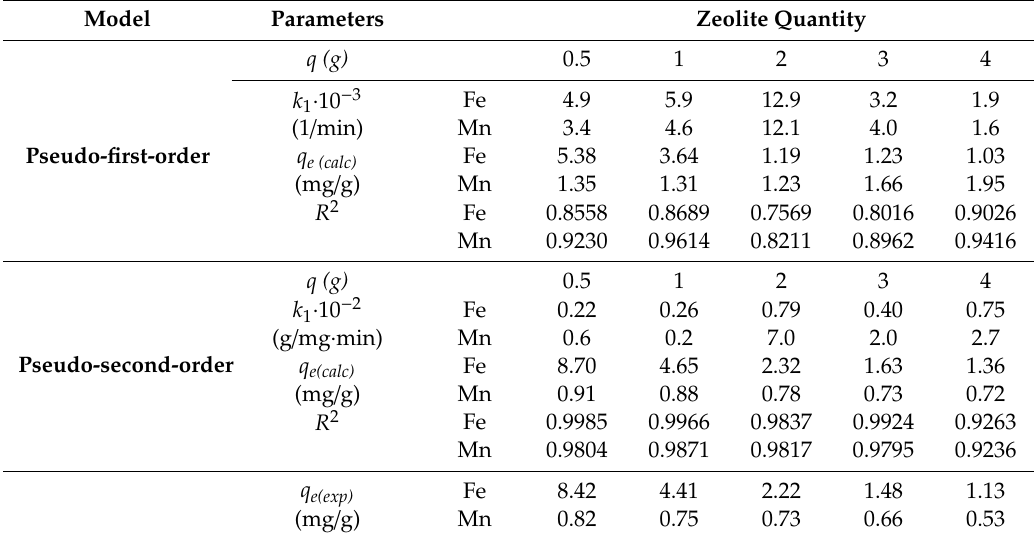
Table 5. Pseudo-first-order and pseudo-second-order kinetic constants for simultaneous removal of Fe and Mn removal on thermally activated NZ 200 at di ff erent adsorbent